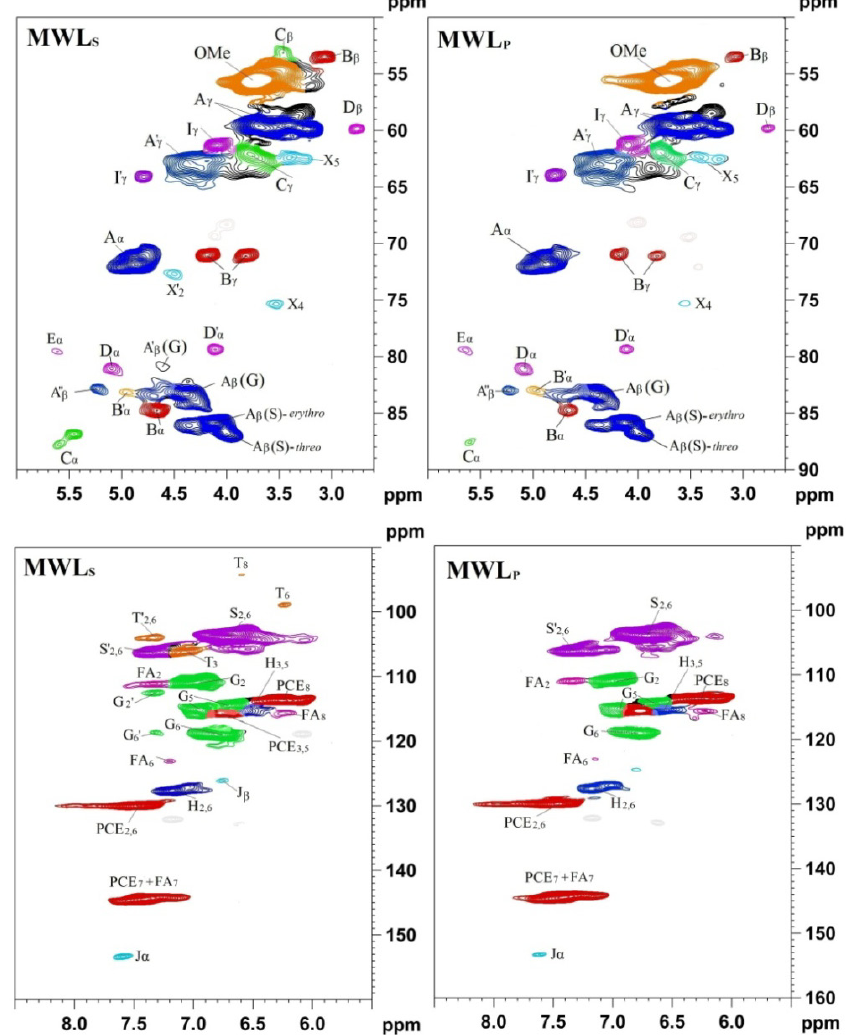
Figure 4. 2D-HSQC NMR spectra of non-acetylated bamboo MWL specimens (MWL represents MWL extracted from bamboo stem. MWL bamboo pith. The structural features of A, B, C, D, and E are depicted in Figure 6. (Reprinted from [28]. Copyright 2013 De